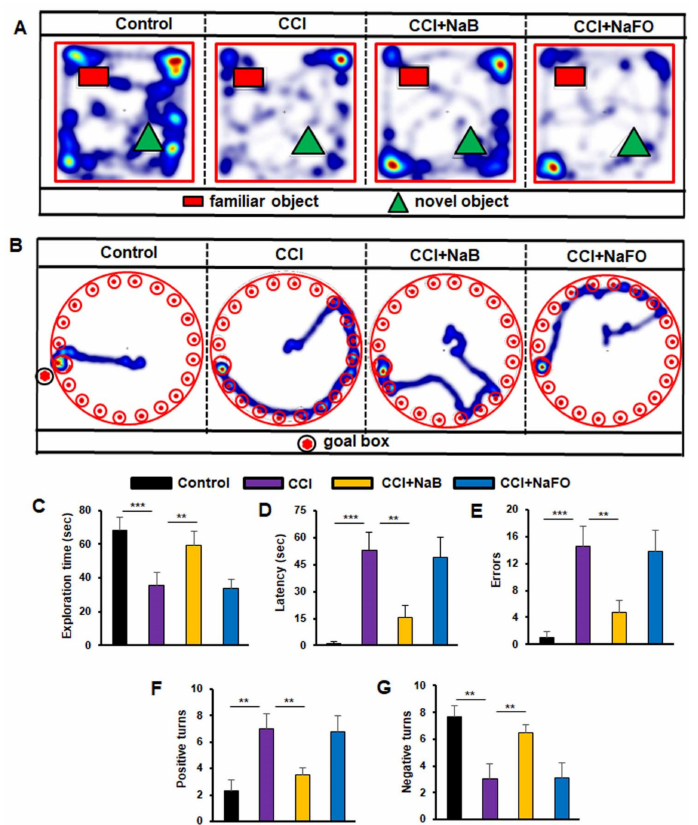
Figure 6. Effect of NaB treatment on spatial learning and memory in mice with CCI injury. Mice were treated with NaB or NaFO orally (50 mg/kg/day) from 24 h after the induction of CCI injury. Following 21 days of treatment, mice were tested by the novel object recognition test (( A ), heat map; ( C ), exploration time), Barnes maze (( B ), heat map; ( D ), time taken; ( E ), number of errors) and T-maze (( F ), positive turns; ( G ), negative turns). Six mice were used in each group. Statistical analyses were performed by one-way ANOVA followed by Tukey’s post hoc test for the novel object recognition test (exploration time: (*** p < 0.0001) vs. control; (** p < 0.0099) vs. CCI injury); Barnes maze test (time taken: (*** p < 0.0002) vs. control; (** p < 0.0014) vs. CCI injury, and number of errors: (*** p < 0.0006) vs. control; (** p < 0.0012) vs. CCI injury); and T-maze (positive turns: (** p < 0.0063) vs. control; (** p < 0.0035) vs. CCI injury, and negative turns: (** p < 0.0064) vs. control; (** p < 0.0035) vs. CCI